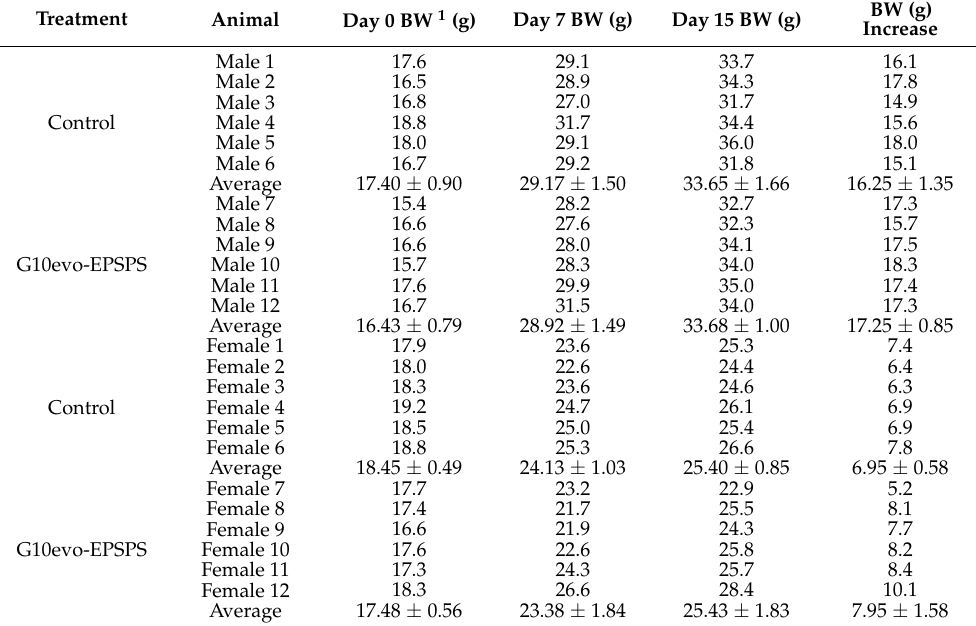
Table 2. Body weight of mice fed with G10evo-EPSPS Protein.